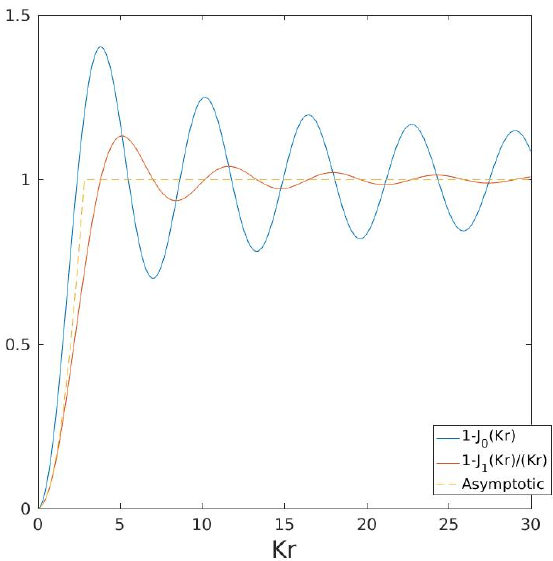
Figure 1. The high pass filter, used in converting the energy spectra function (in red ). The filter of Bennett (1984) is shown for comparison (in blue ). Also shown is the approximate filter (17) (the dashed curve), based on the asymptotic limits of the full filter.